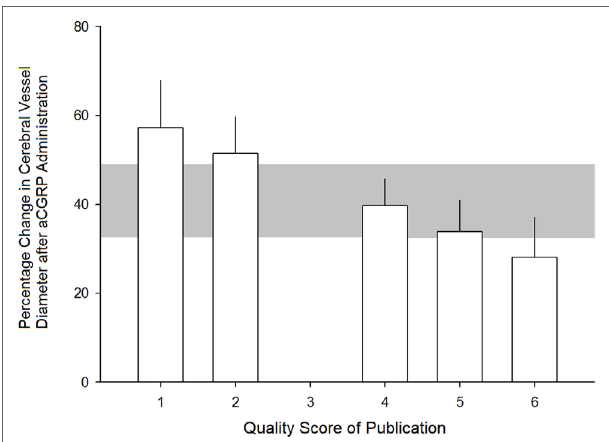
FiGURe 4 | Relationship between quality score of studies and estimated efficacy of alpha calcitonin gene-related peptide at dilating cerebral arteries. See Section “Methods” for quality scoring criteria. Error bars represent SE while the gray area represents the grouped (all studies) estimate. Differences were not statistically significant ( p >